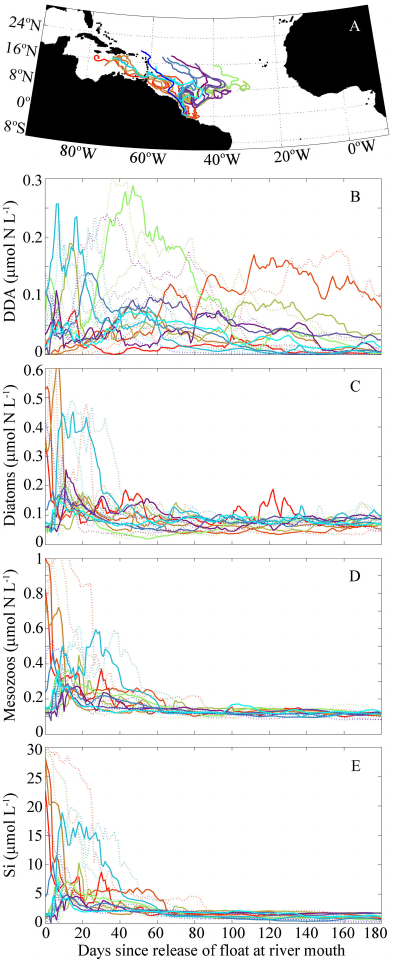
Figure 6. Float trajectories for synthetic Lagrangian floats released at river mouth. Panel (A) shows 20 randomly chosen float tracks (180 days shown for each float). Panels (B) , (C) , (D) , and (E) show the concentration of DDAs, diatoms, mesozooplankton, and Si, re- spectively experienced by these 20 random floats. Colors match be- tween panels. For ease of differentiating individual float tracks in Panels (B–E) , half of the tracks are shown as dotted rather than solid lines.